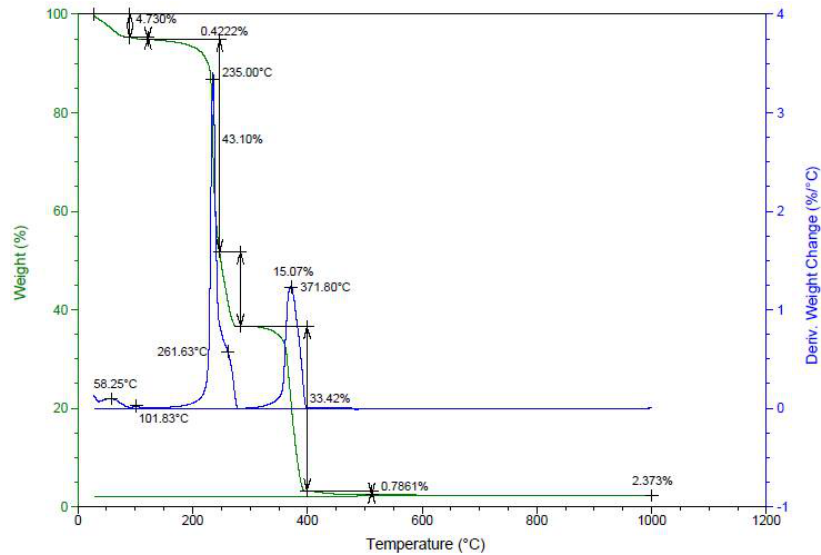
Figure 6. Thermogravimetric analysis of poplar wood lignin in an inert atmosphere.